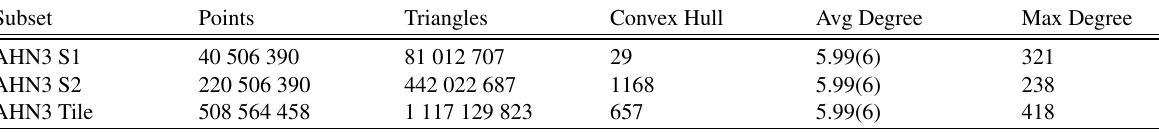
Table 2: AHN3 Inputs